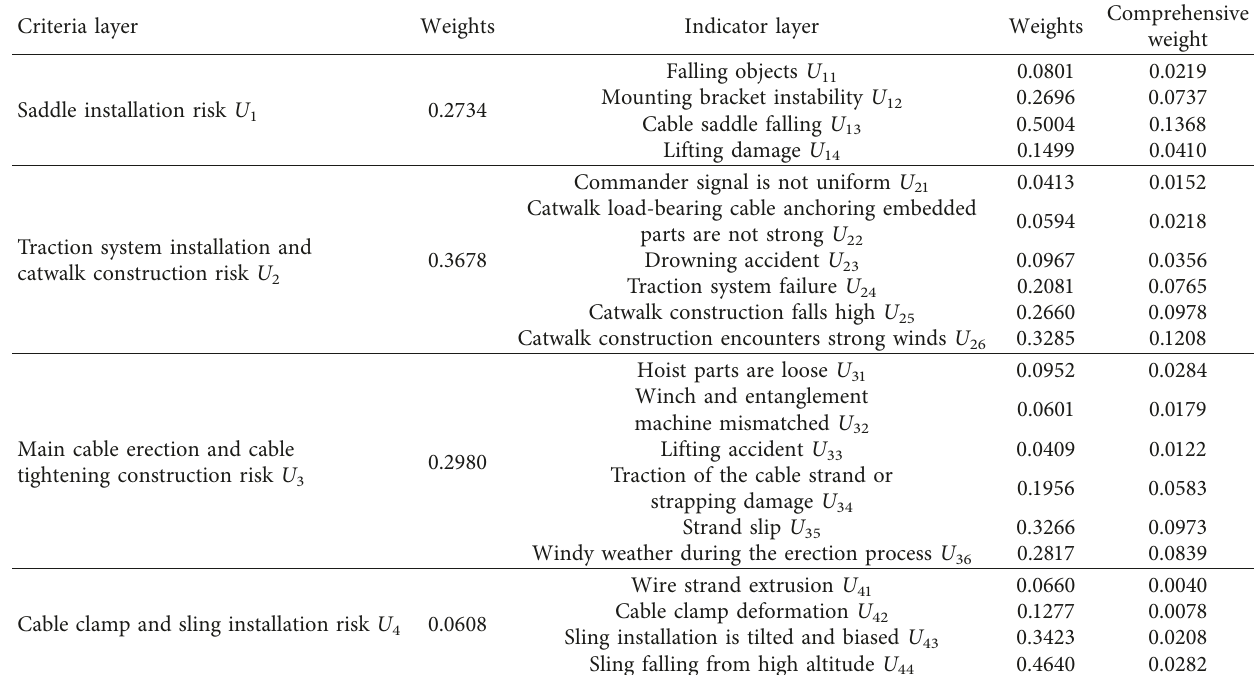
Table 3: Index weight of the cable system construction risk evaluation system.